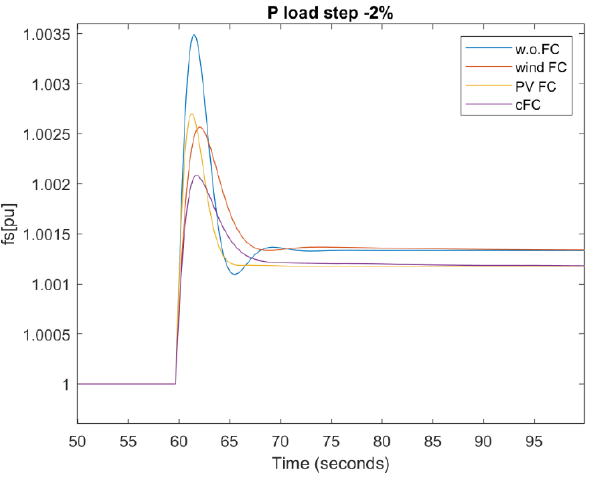
Figure 13 . Simulation 3 frequency trend. Figure 13. Simulation 3 frequency trend.